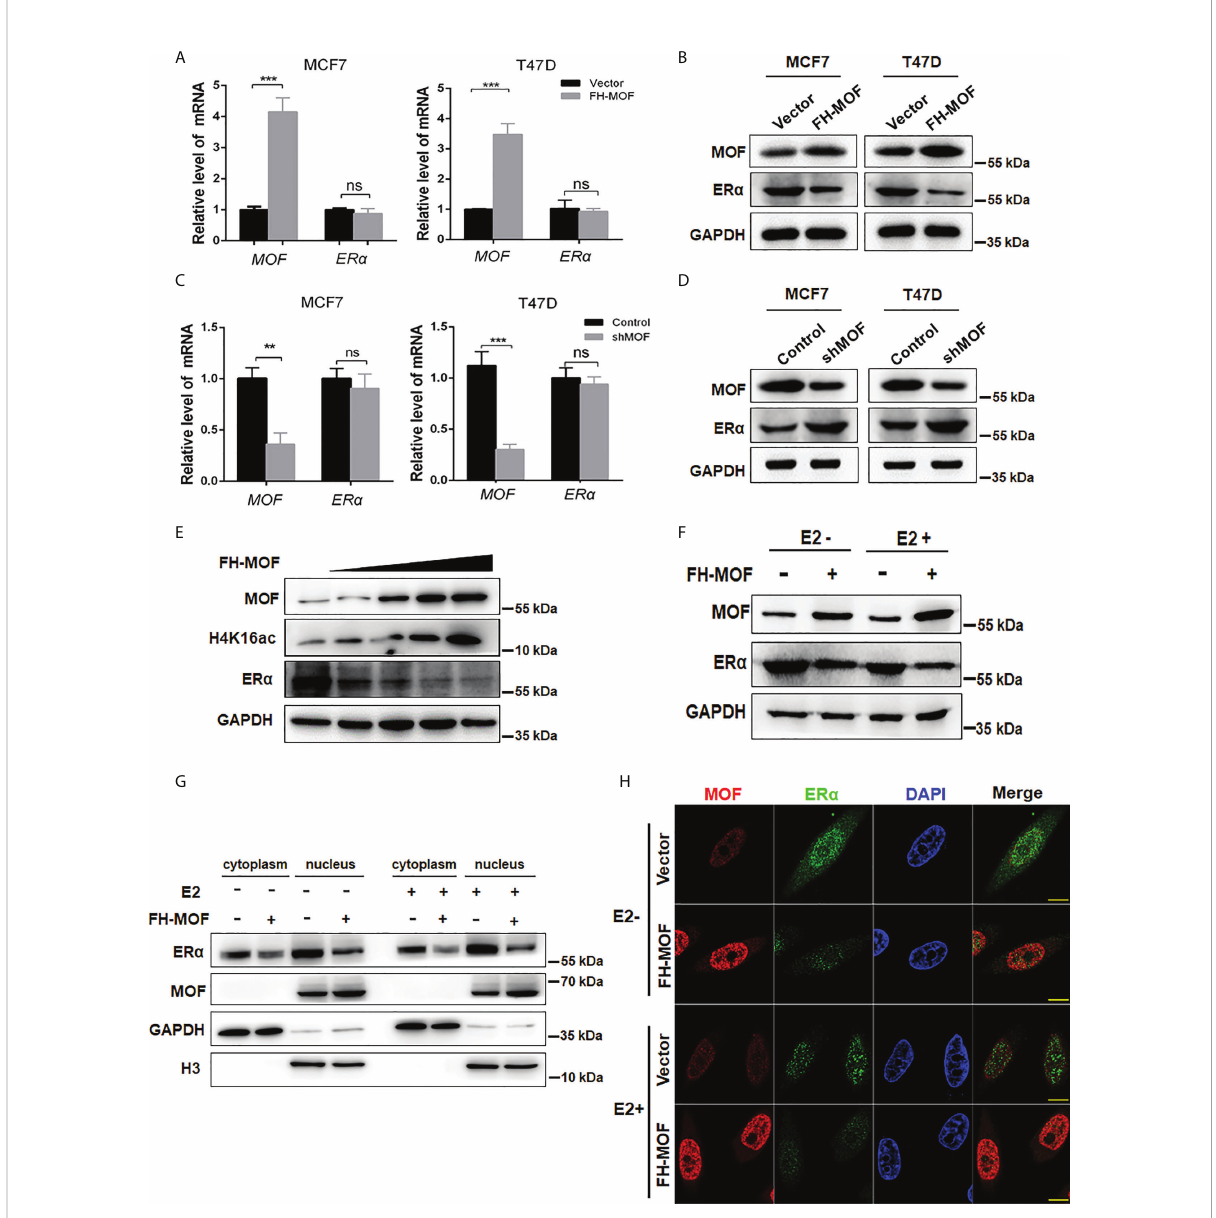
FIGURE 2 Effects of MOF overexpression on the expression of ER a in BC cells. (A, B) Effects of MOF overexpression on the steady-state mRNA levels and protein abundance of ER a in MCF7 and T47D cells were examined by qRT-PCR and Western blot assays. (C, D) MOF knockdown was performed by shMOF plasmid transfection to determine the expression of ER a at the mRNA and protein levels. (E) Increased doses of Flag-HA- MOF plasmid were transfected into MCF7 cells to examine the alteration trend of ER a protein levels. (F) Examination of the ER a protein level by MOF overexpression in the absence or presence of E2 treatment. After transfection with Flag-HA-MOF plasmid or empty vector as control for 48 h, MCF7 cells were treated with 10 nM E2 for 3h. (G) The protein expression of ER a by MOF in both cytoplasm and nucleus was determined by nuclear and cytoplasmic separation assay regardless of the presence of E2 in MCF7 cells. (H) Immuno fl uorescence staining assay was conducted to detect the expression of ER a in MOF-overexpressed MCF7 cells. Bar = 10 m m. ***P < 0.001 and **P < 0.01 vs. control group. ns, not signi fi cant vs.